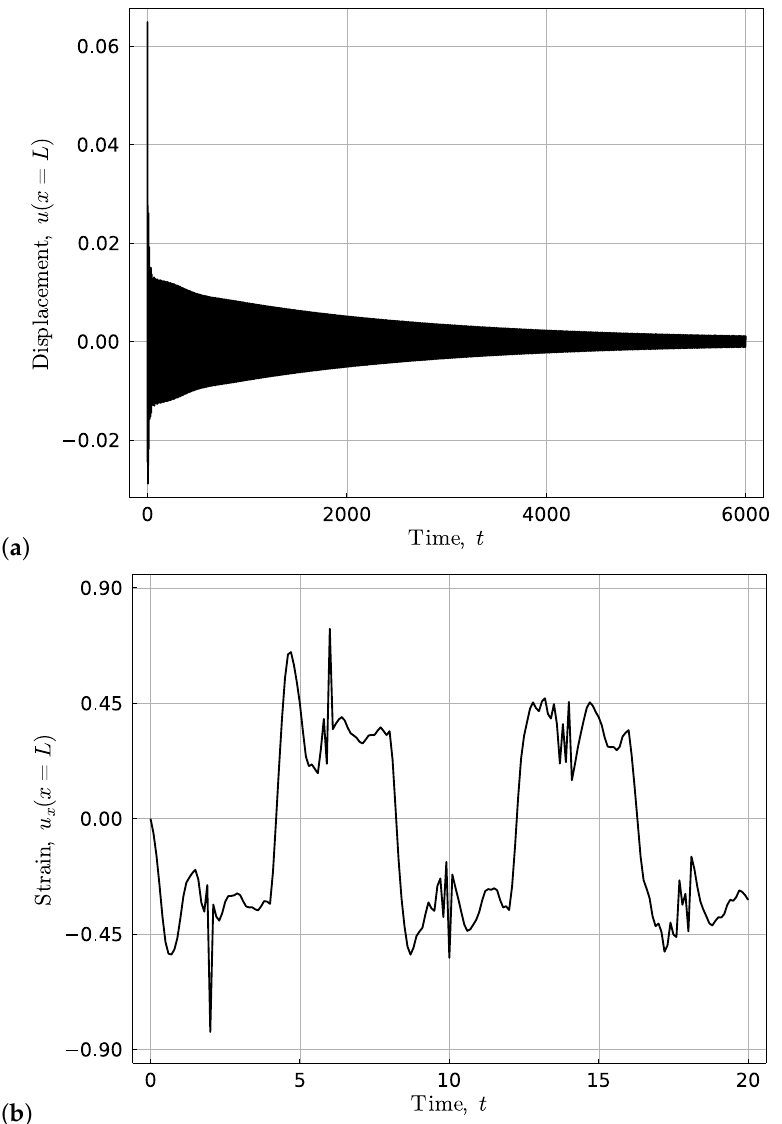
Figure 4. The optimal design of the decay of the impact wave. The corresponding ( a ) terminal displacement and ( b ) strain response of the rod. The response is calculated with N =